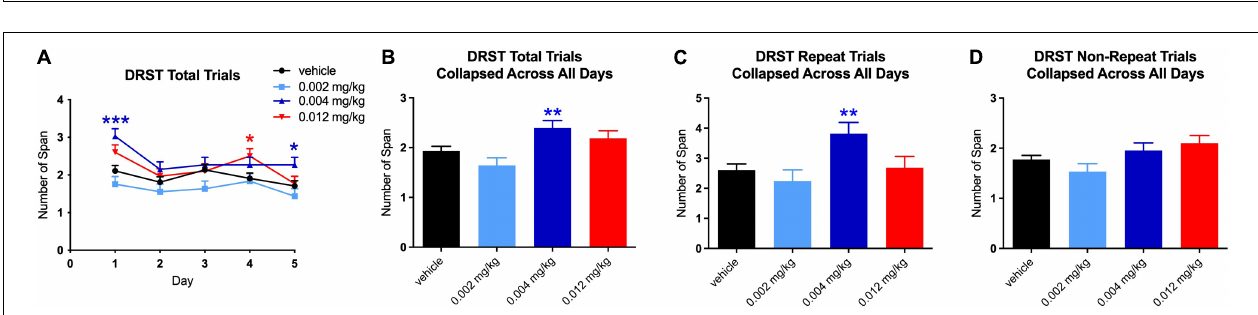
FIGURE 2 | Effect of PF-6294 on performance on the basic DNMS task (A) on individual testing days at each dose (B) collapsed across all days and (C) on the delayed version without interference and (D) with interference. No dose had a significant effect on performance on any version of the task. Error bars = SEM.